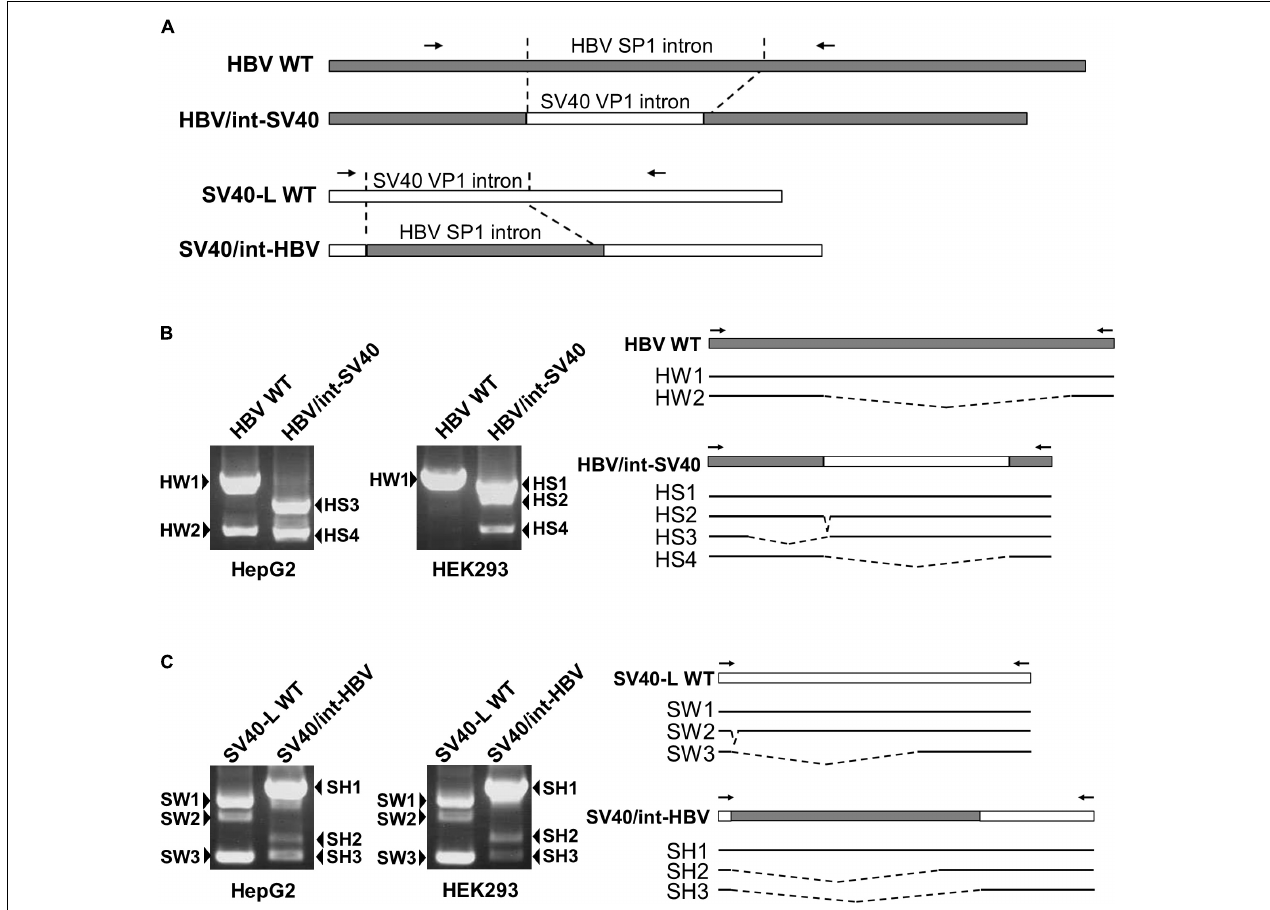
FIGURE 2 | Identification of cis -regulatory elements involved in HBV 3.5-kb RNA splicing in cell-type dependent and -independent manners. (A) A schematic representation of constructs and PCR primers used in the intron-swapping experiment is indicated. (B) HBV WT and HBV/int-SV40 were expressed in HepG2 and HEK293 cells. PCR products were analyzed by agarose gel electrophoresis (left). Schematic of unspliced and spliced forms detected is shown (right). (C) SV40-L WT and SV40/int-HBV were expressed in the cells and PCR products were analyzed as shown in (B)